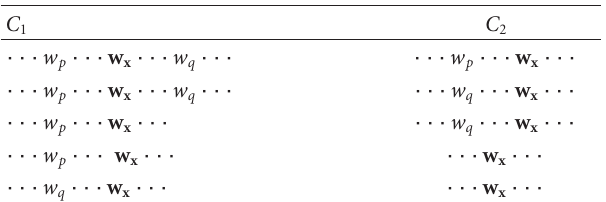
Table 1: An example of a training corpus of 10 instances of an ambiguous word w x where 5 instances are in the first sense listed under class label C 1 and 5 instances of the second sense listed under class C 2 . The context word w p has 4 and 1 occurrences in Class C 1 and C 2 , respectively, while w q has 3 and 2 occurrences in C 1 and C 2 , respectively. C 1